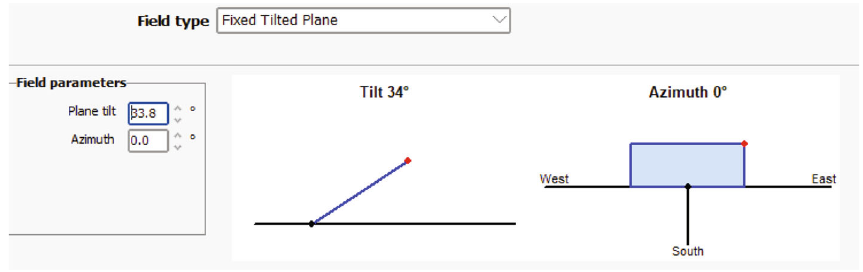
Figure 18: The orientation of the PV in fi xed mode.